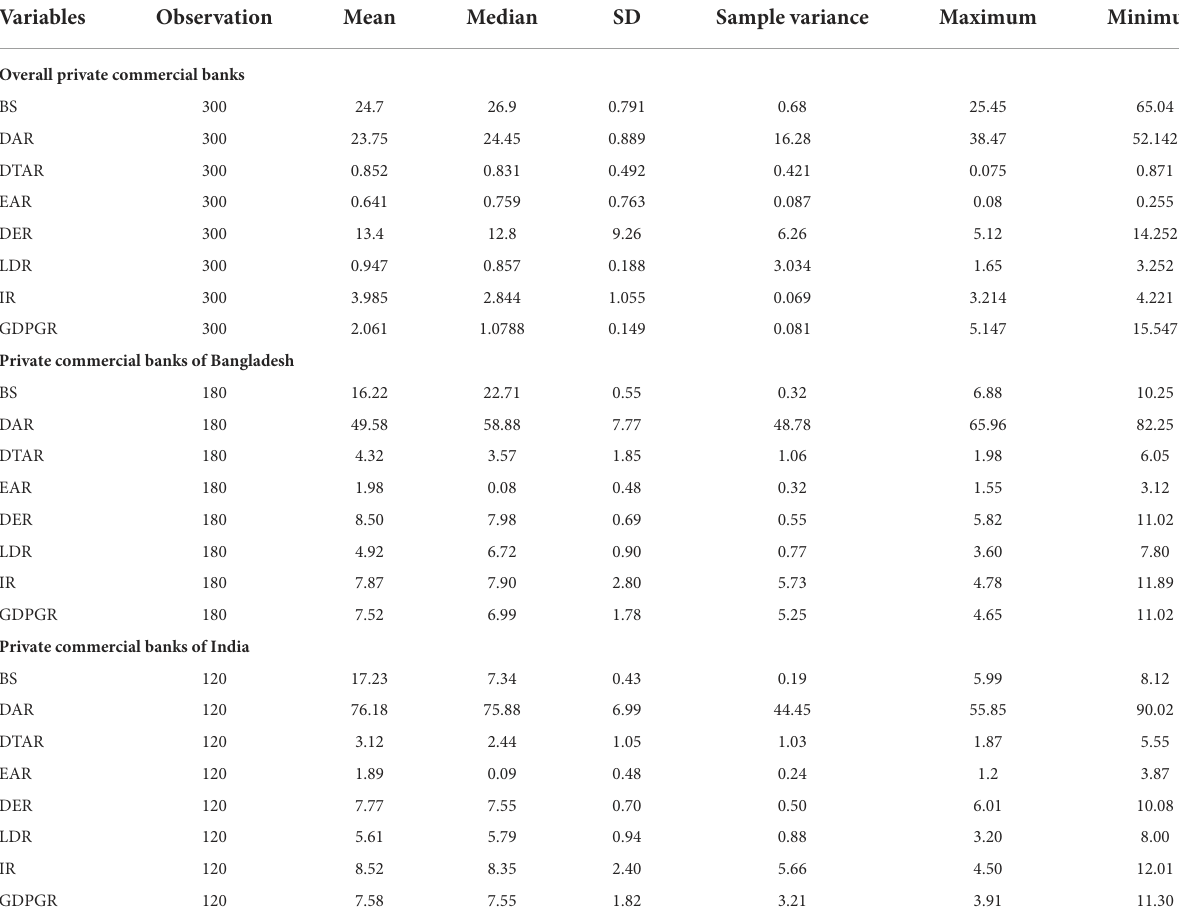
TABLE 7 Summary of the independent